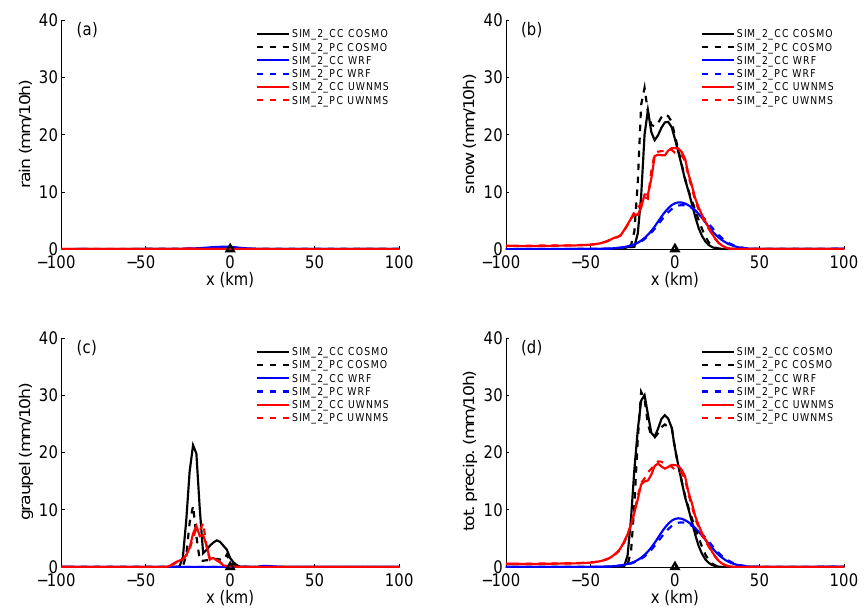
Fig. 11. Same as Fig. 9 but for the clean case simulation SIM 2 CC (solid) and the polluted case simulation SIM 2 PC (dashed), respectively.